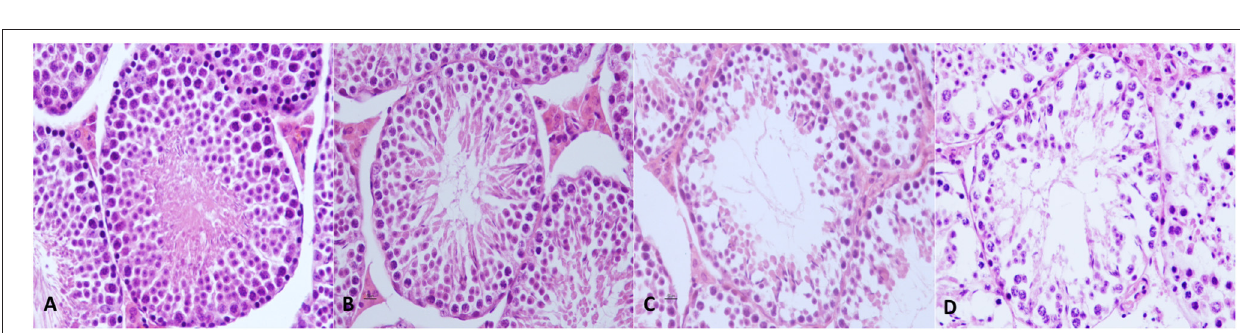
FIGURE 3 | Mouse testis from control and experimental groups. (A) Testes from mice of the control group showed normal histoarchitecture with uniform, well-organized seminiferous tubules, and complete spermatogenesis. (B) In experimental group 1, no severe and significant alterations were observed in testicular parenchyma nor in spermatogenesis. (C) In experimental group 2, transverse sections of the testis showed scattered mild to moderate alterations, which were present mostly in the multifocal detachment of germinal epithelium, irregular and buckled basement membrane, tubular deformation and degeneration, shrunken seminiferous tubules, and increased luminal diameter. (D) In experimental group 3, mild alterations such as the detachment of germinal epithelium and reduced population of mature spermatozoa are shown. Hematoxylin and eosin, original magnification 40 ×